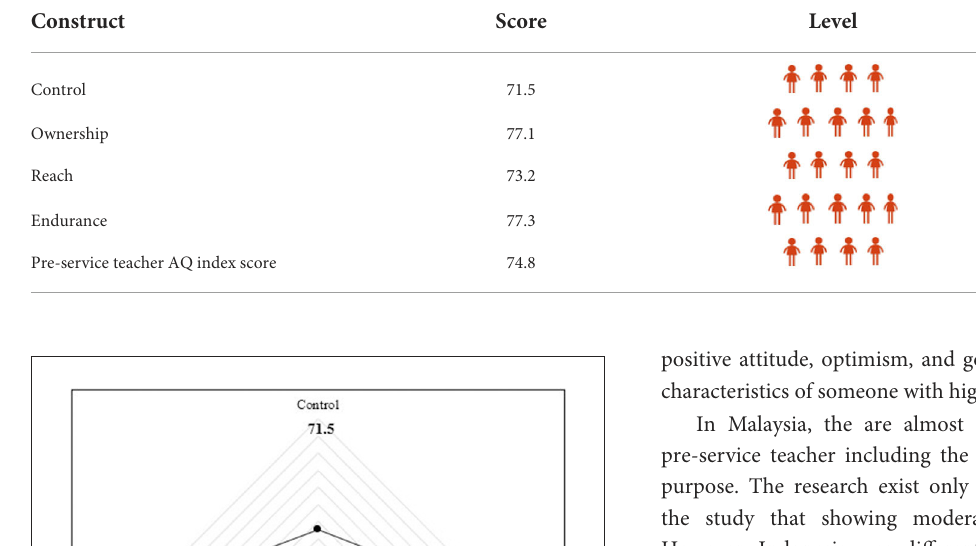
TABLE 10 Overall AQ index